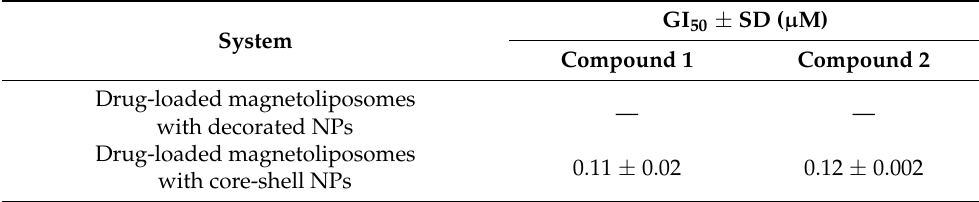
Table 8. Growth inhibitory concentrations (GI 50 ) in NCI-H460 lung cancer cell line. The results are from three independent experiments (performed in triplicate) and are expressed as mean ± standard deviation (SD).